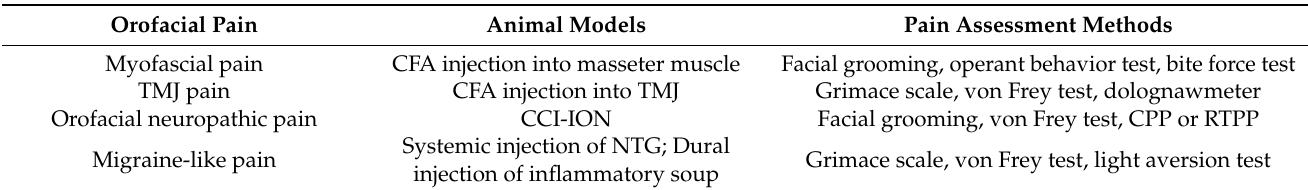
Table 2. Pain assessment methods for different orofacial pain in animal